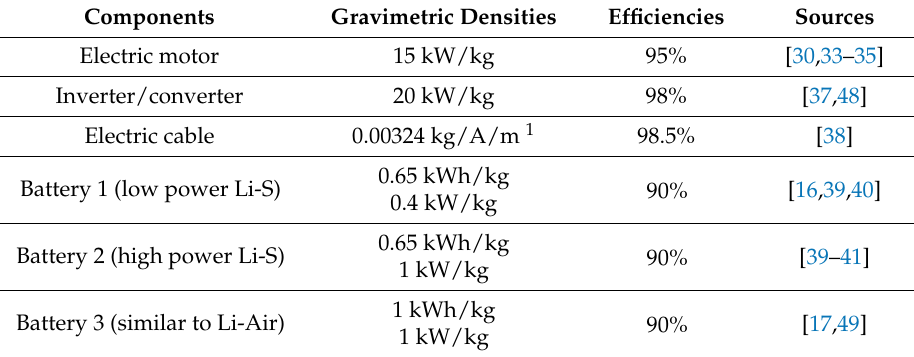
Table 1. Overview of electric propulsion components